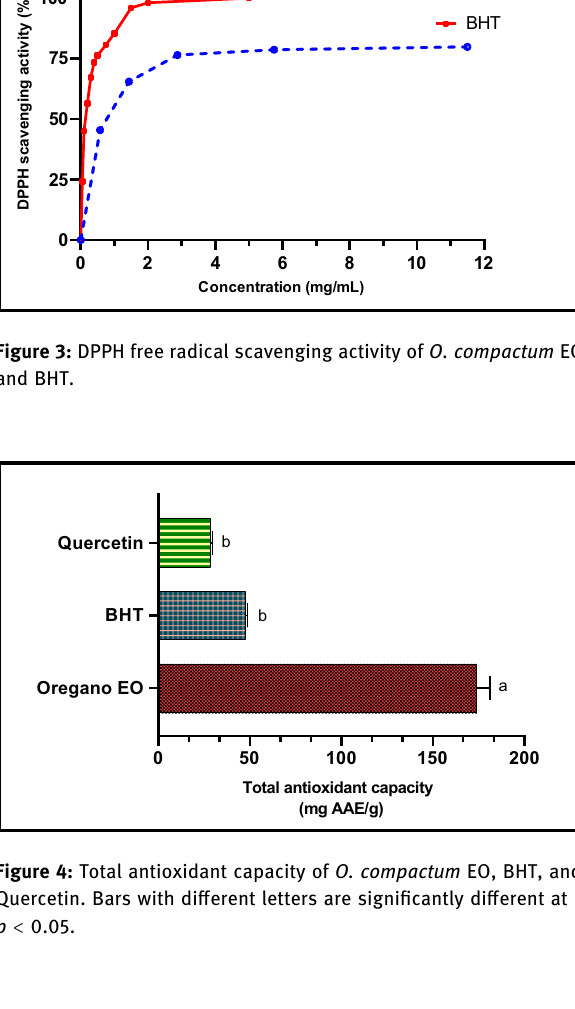
Table 2: Antioxidant activities of Oregano EO and standards ( means